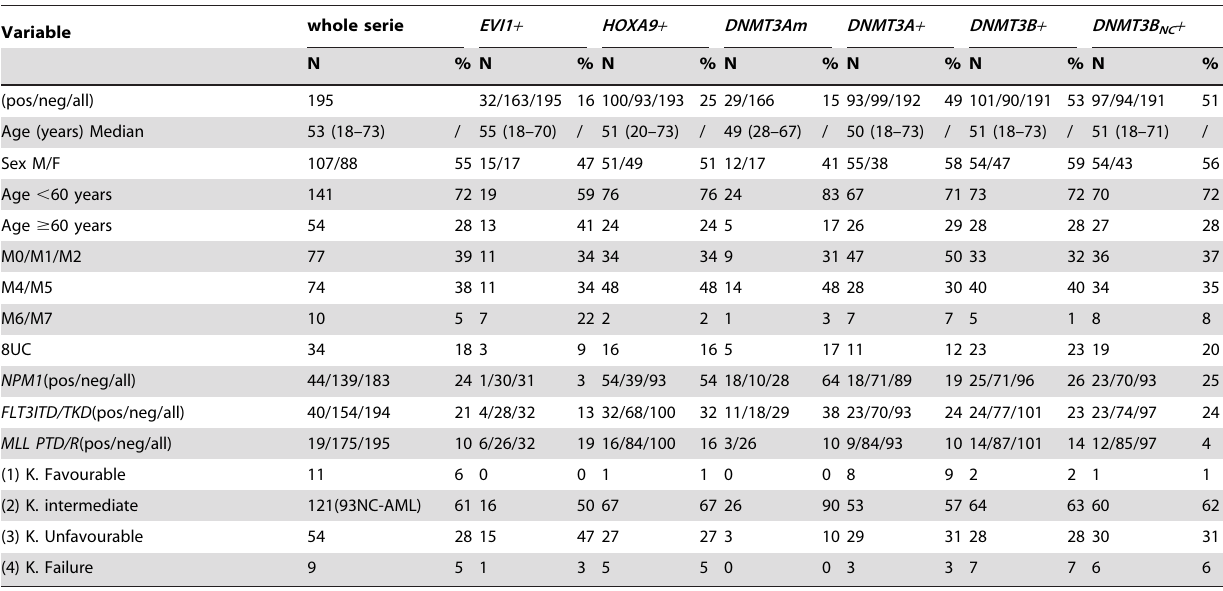
Table 1. Characteristics of the patients.